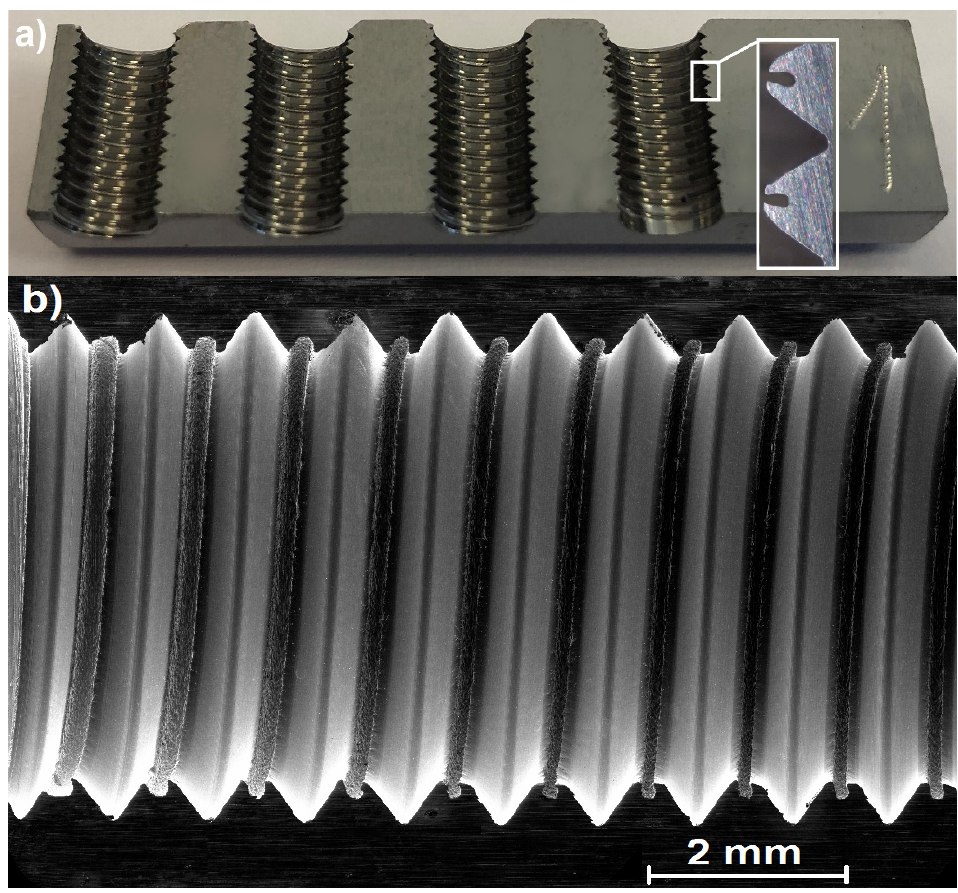
Figure 9. Cross-sections of the threads ( a ) after cutting and polishing; ( b ) the SEM of the cross- section.